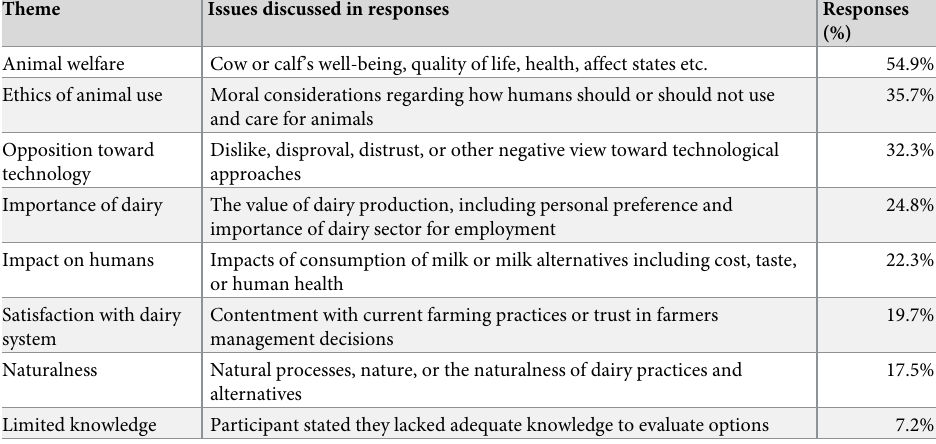
Table 4. Themes from open-ended responses to the question “please explain your responses above” following the Likert responses regarding support for five different approaches to dairy cow welfare issues.